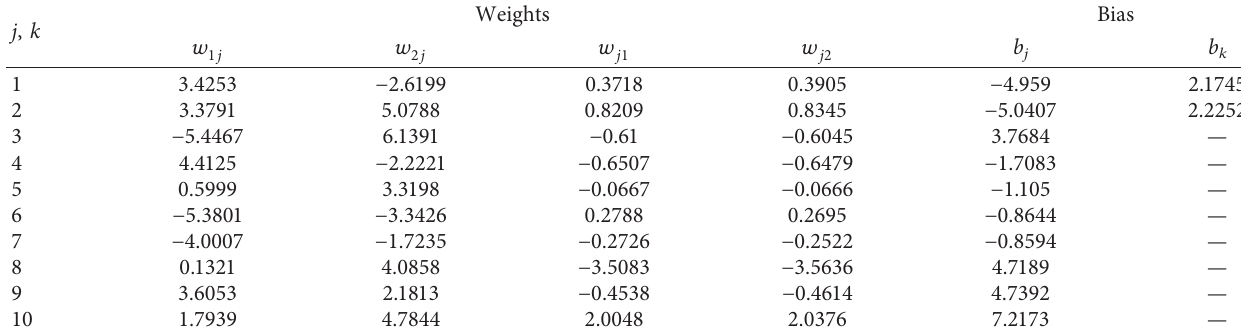
Table 5: Weights and biases for the obtained neural network.